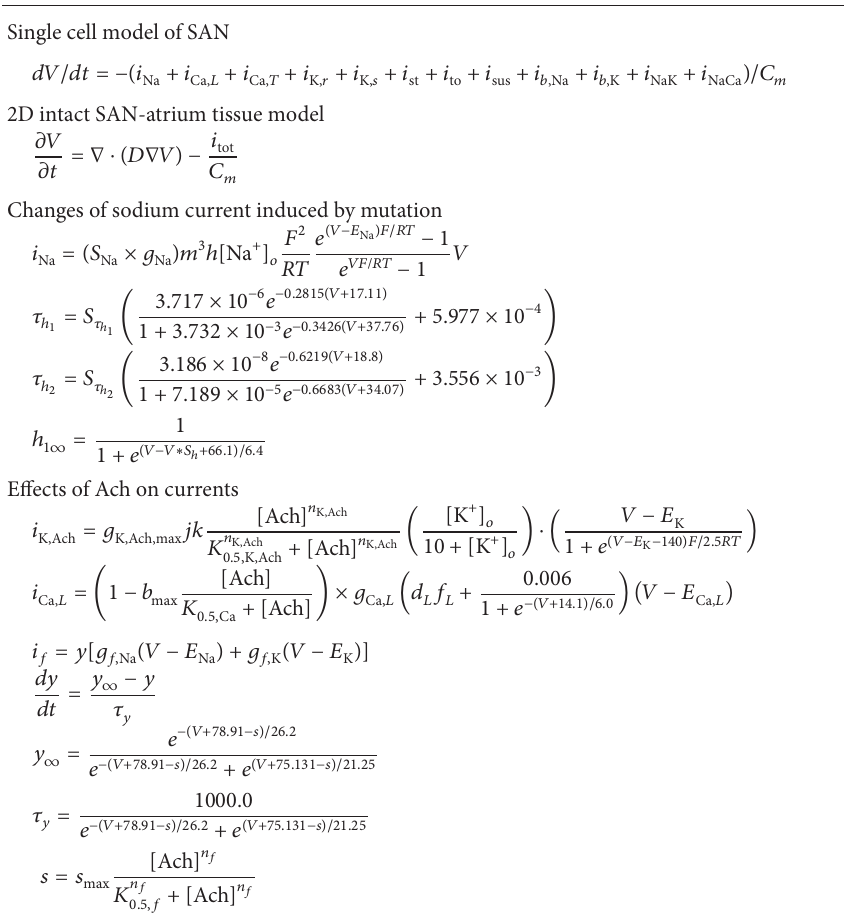
Table 1: Model equations of the SAN single cell, 2D tissue, and some channel currents. Single cell model of